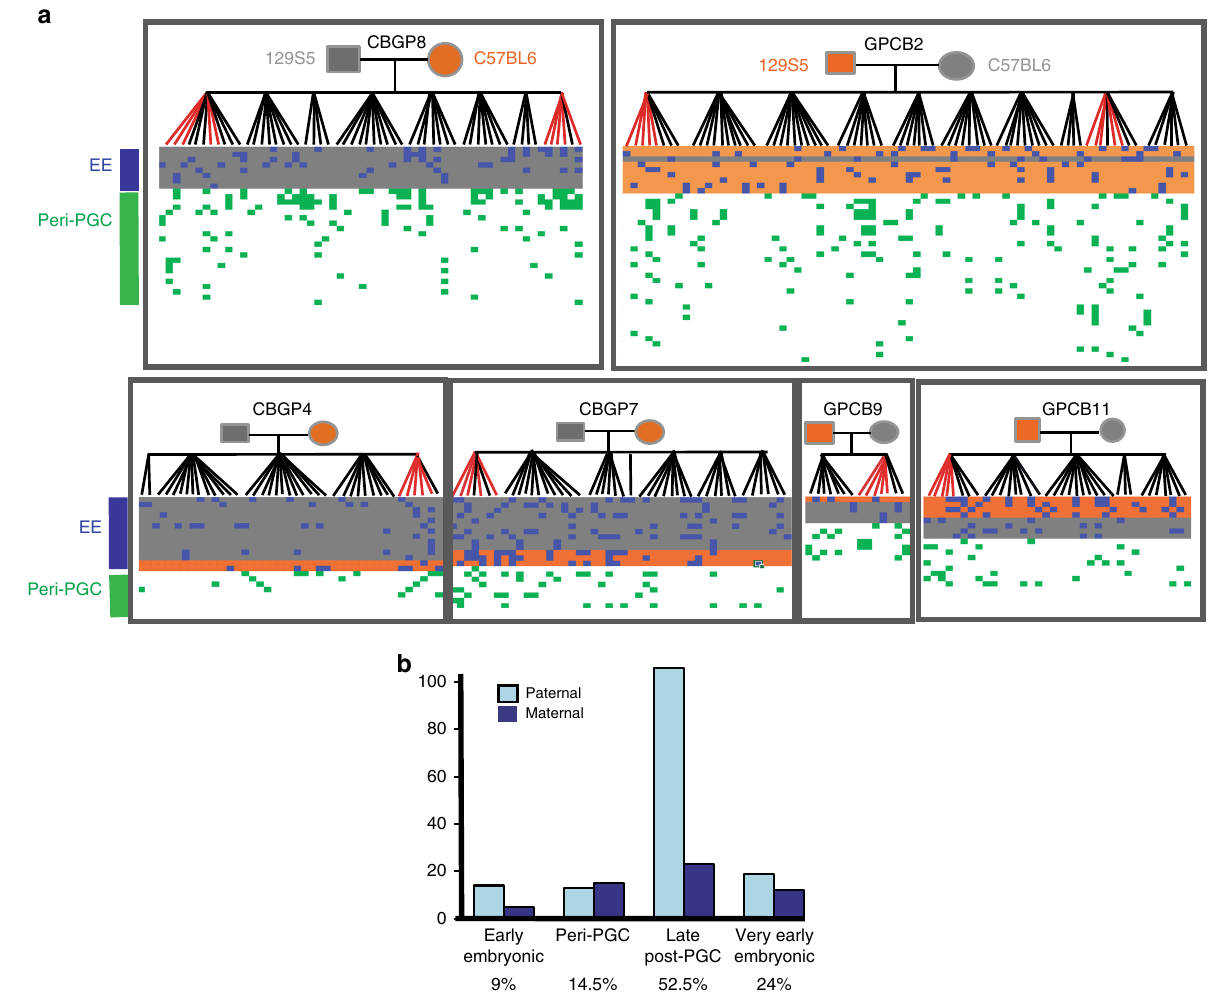
Fig. 3 Timing of mutations in six mouse pedigrees. a Validated de novo mutations in six mouse pedigrees. Offspring are shown vertically, and DNMs are shown horizontally, coloured according to temporal strata. Early embryonic DNMs are shaded according to the parental origin (grey/orange). Late post- PGC and VEE mutations are only observed in one individual and are listed in Supplementary Table 1 and Supplementary Data 1. b The number of DNMs assigned to the paternal or maternal haplotype ( ‘ Methods ’ ) in each temporal strata, with the total contribution of mutations in each strata to the overall rate shown at the bottom of the graph Table 1 Autosomal SNV germline mutation rates per generation, per year and per cell division in humans and mice Mouse Mutations per genome per